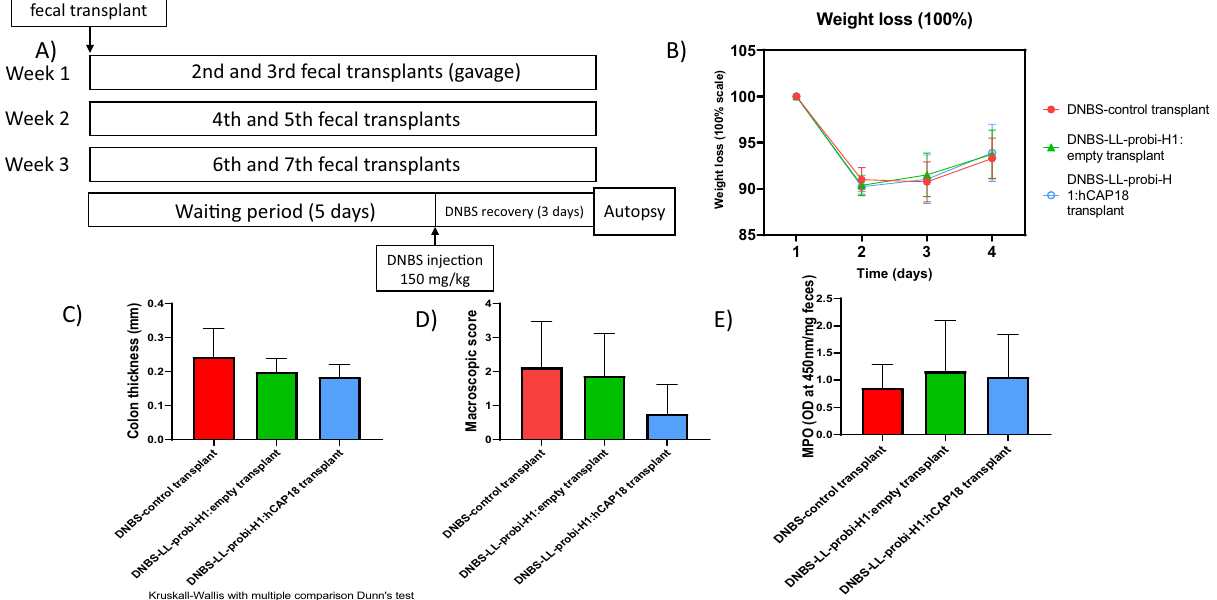
Figure 6. Effect on DNBS-induced colitis of fecal transplant from donor mice that were gavaged with LL-Probi- H1:empty or LL-Probi-H1:hCAP18. ( A ) Experimental protocol of PEG washing and fecal transplant. ( B ) Mouse weight loss. ( C ) Colon thickness. ( D ) Macroscopic score. ( E ) MPO activity. Data represent mean ± SD. *P < 0.05, **P < 0.01, ***P < 0.001, ****P < 0.0001, n = 8 mice per